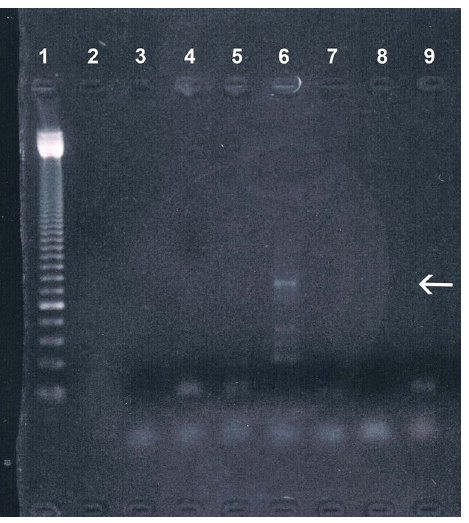
Figure 8. Molecular analysis of Trypanosoma cruzi ancient DNA. The agarose gel electrophoresis shows in lane 6 a positive amplicon of the expected size (arrow). (Lane 1: molecular weight standard; lanes 2–3: blank controls; lane 4–5: negative controls; lane 6– 7: rectal wall tissue specimen of the mummy; lane 8–9: blank controls).